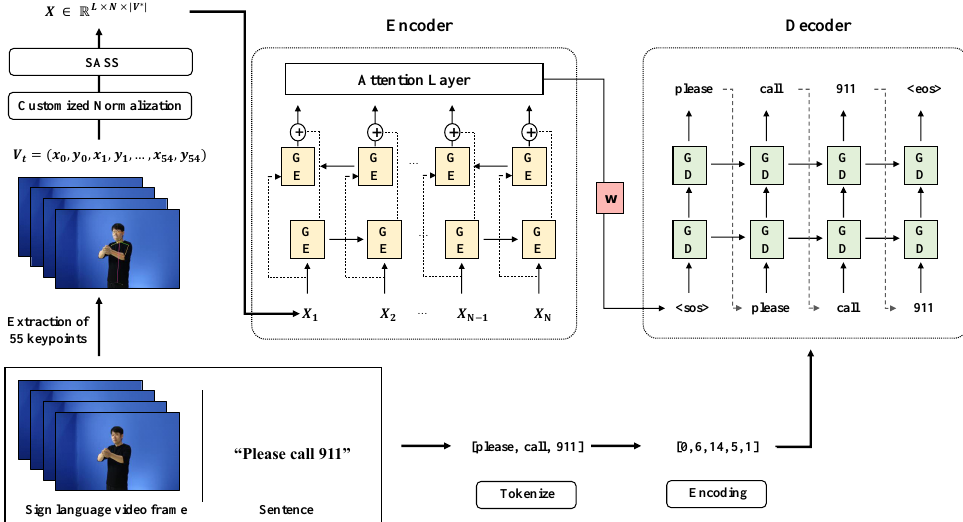
Figure 2. The Full Architecture of our SLT approach. We extract the keypoint vector from each frame and then go through the process of normalizing features. Subsequently, after adjusting the number of frames, encoding is performed. After tokenizing the text, it is put into the decoder through the embedding process. In this case, GE is GRU-Encoder, GD is GRU-Decoder and X is the encoding vector that enters the